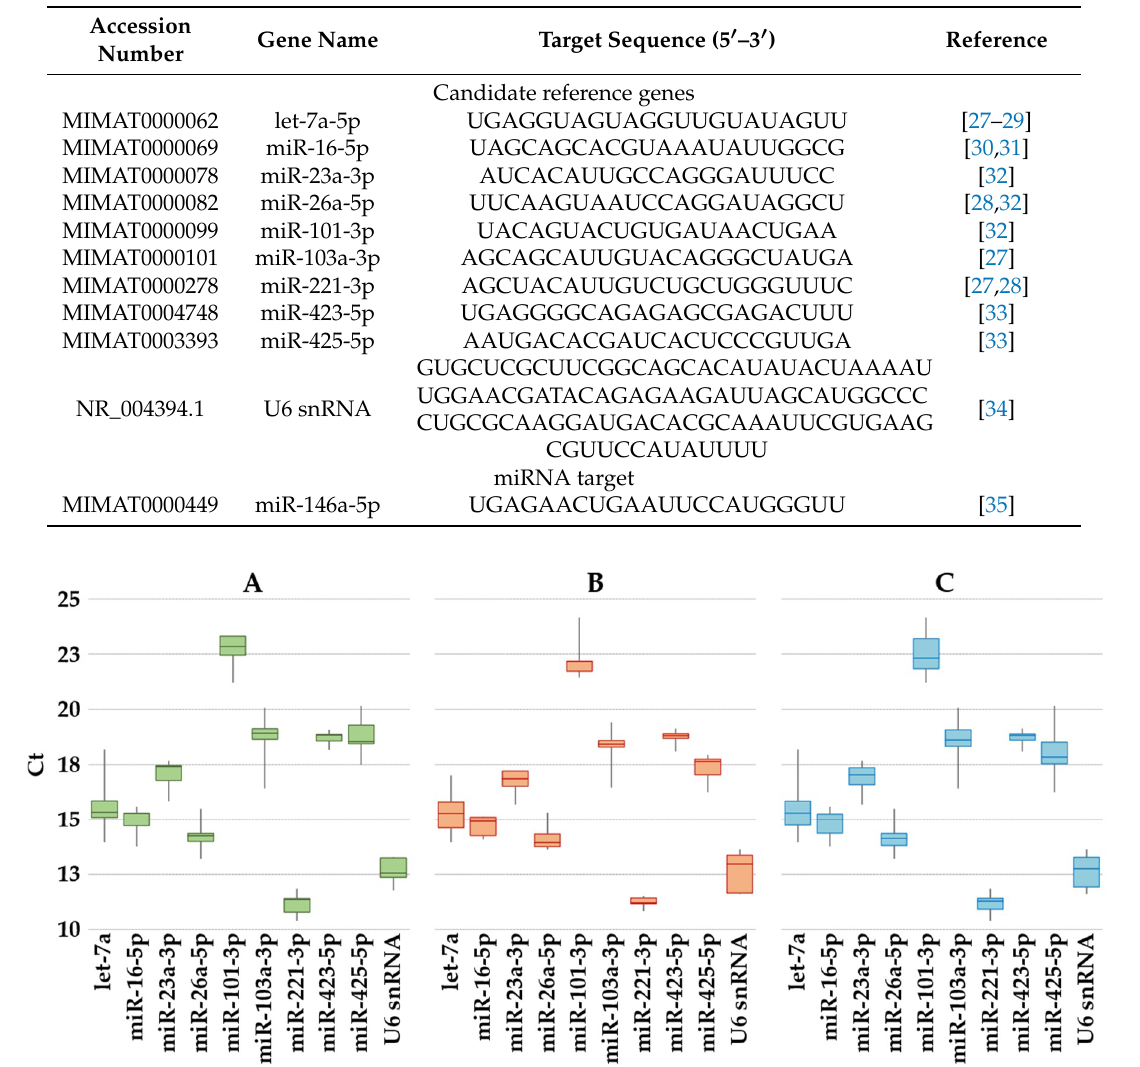
Table 1. Candidate reference genes and target gene primer sequences.